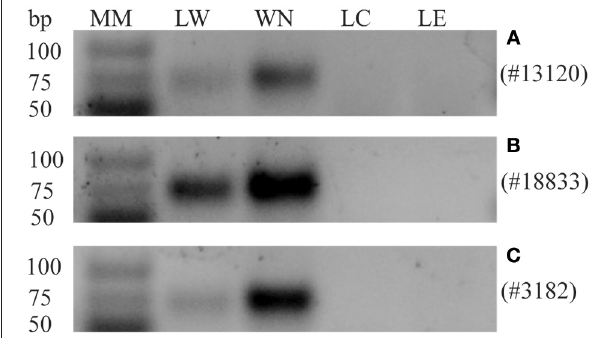
FIGURE 4 | Detection of candidate transferred whitefly sRNAs in the nymph and leaflet samples by stem-loop RT-PCRs. Expression of sRNAs in: leaflet first infested with whiteflies but with adults and nymphs subsequently removed (LW), whitefly nymphs (WN), control leaflet (LC) or leaflet with eggs (LE). (A) sRNA #13120, a specific band is detected in LW and WN but not in LC and LE. (B) #18833, a specific band is detected in LW and WN but not in LC and LE. Similar results for #13120 and #18833 were obtained in four biological replicates. (C) #3182, a specific band is detected in LW and WN but not in LC and LE in three out of four replicates. One biological replicate showed also a band in LC and LE. Molecular Mass (MM), GeneRuler Ultra Low Range DNA ladder (Thermo